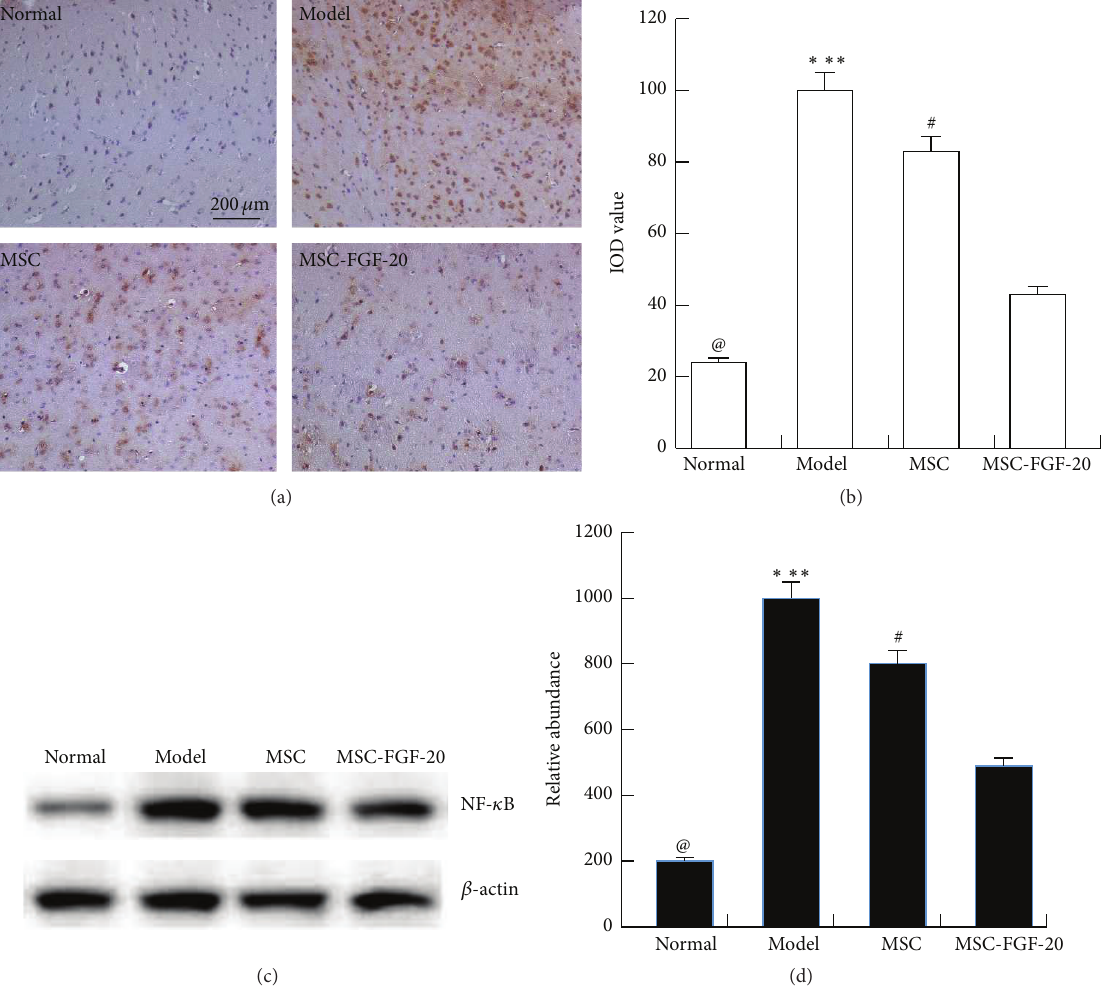
Figure 5: NF- 𝜅 B expressions in the cerebral cortex of PD mice. (a, b) The results of immunohistochemistry showed that the expression of NF- 𝜅 B greatly increased in the model group (scale bar = 200 𝜇 m). After hUC-MSC and hUC-MSC-FGF-20 transplantation, the expression of NF- 𝜅 B significantly decreased in the cerebral cortex of PD mice. (c, d) WB confirmed the results of immunohistochemistry ( @ 𝑝 < 0.01 , the normal group versus the model group; ∗ 𝑝 < 0.05 , the model group versus MSC group; ∗ 𝑝 < 0.01 , the model group versus MSC-FGF-20 group; # 𝑝 < 0.05 , MSC group versus MSC-FGF-20